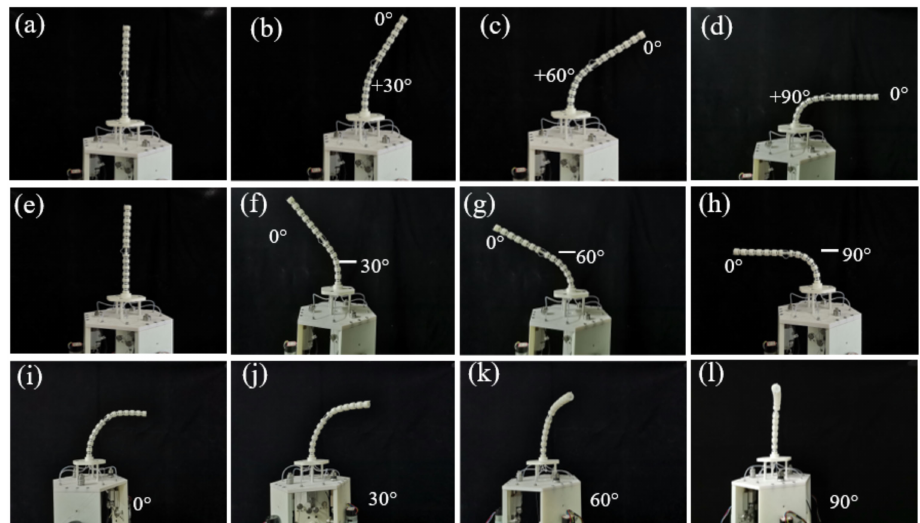
Figure 20. Bending configurations of the proximal segment of the robot. ( a ) The initial configuration. ( b ) The configuration with the bending angle of +30 ◦ . ( c ) The configuration with the bending angle of +60 ◦ . ( d ) The configuration with the bending angle of +90 ◦ . ( e ) The initial configuration. ( f ) The configuration with the bending angle of − 30 ◦ . ( g ) The configuration with the bending angle of − 60 ◦ . ( h ) The configuration with the bending angle of − 90 ◦ . ( i ) The bending configuration. ( j ) The rotating 30 ◦ clockwise of driving mechanism. ( k ) The rotating 60 ◦ clockwise of driving mechanism. ( l ) The rotating 90 ◦ clockwise of driving mechanism.